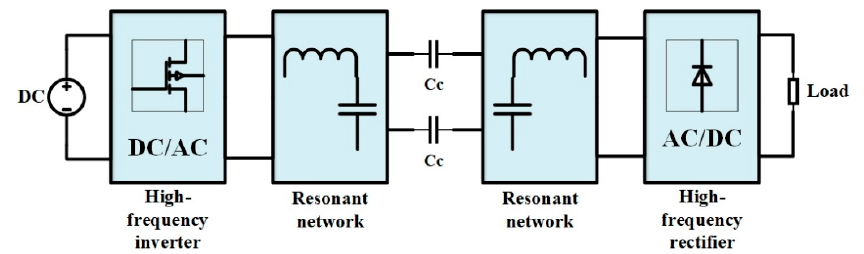
Figure 1. Fundamental block diagram of CPT.